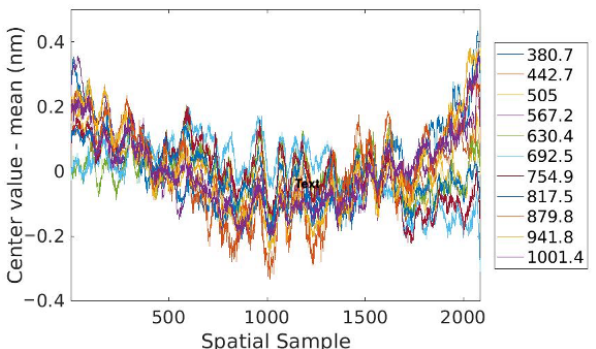
Figure 10. The relative center wavelengths as a function of spatial samples for 11 selected spectral columns.